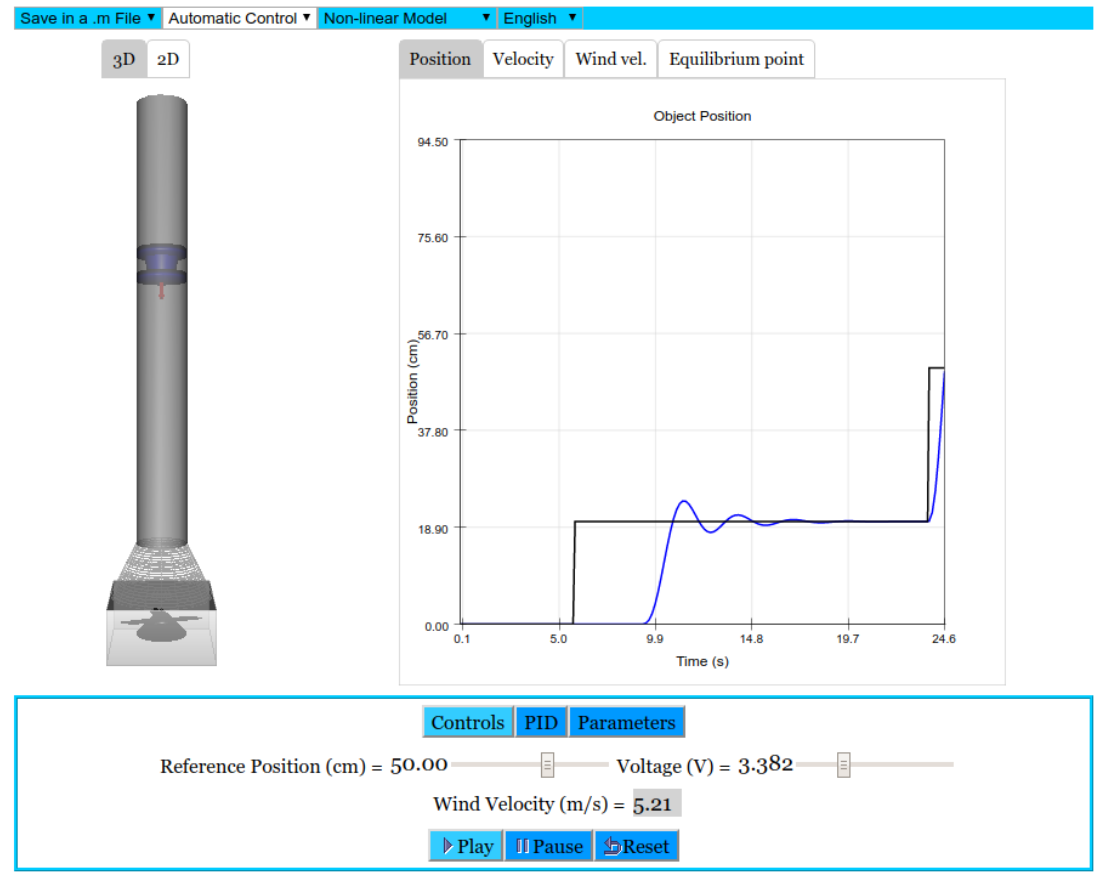
Figure 5. The virtual lab of the air levitation system.